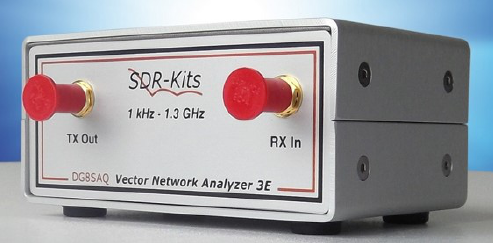
Figure 24. Small-sized Vector Network Analyser.